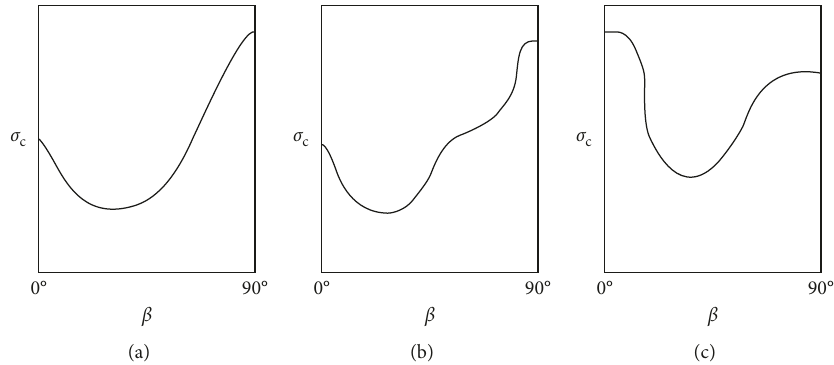
Figure 2: Classification of anisotropy for transversely isotropic rocks (after Ramamurthy [7]): (a) U type; (b) undulatory type; (c) shoulder